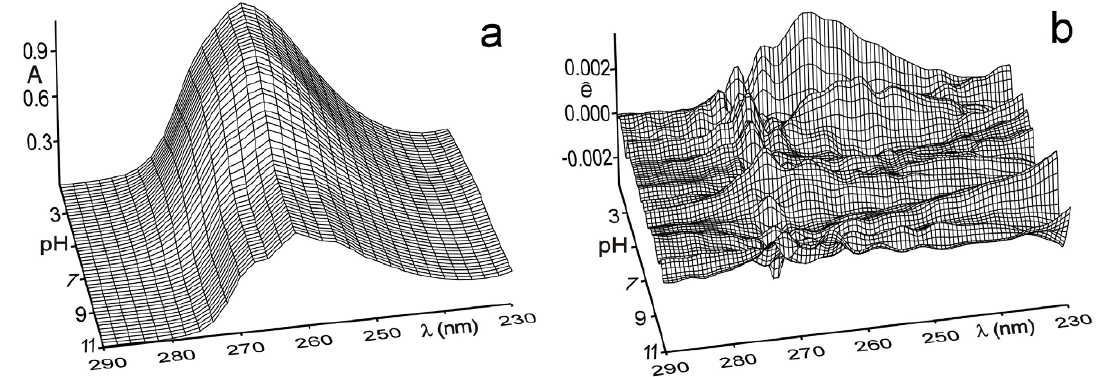
Figure 2. (a) The 3D-absorbance-response-surface representing the measured multiwavelength absorption spectra for risedronate depending on pH at 25°C, (b) the 3D-residuals map after a non-linear regression performed with SPECFIT/32 and SQUAD(84) programs,